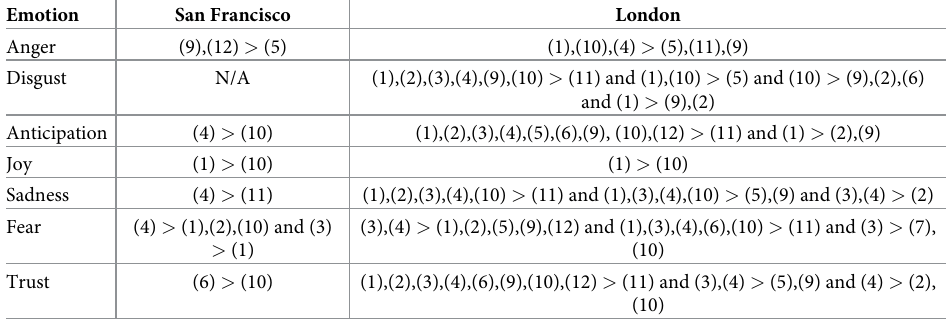
Table 4. Results of significantly different categories: (1): Hotel & Restaurants, (2): Commercial Services, (3): Attractions, (4): Sports & Entertainment, (5): Education & Health, (6): Public Infrast., (7): Manufacturing & Pro- duction, (9): Retail, (10): Transport, (11): Residential, (12):